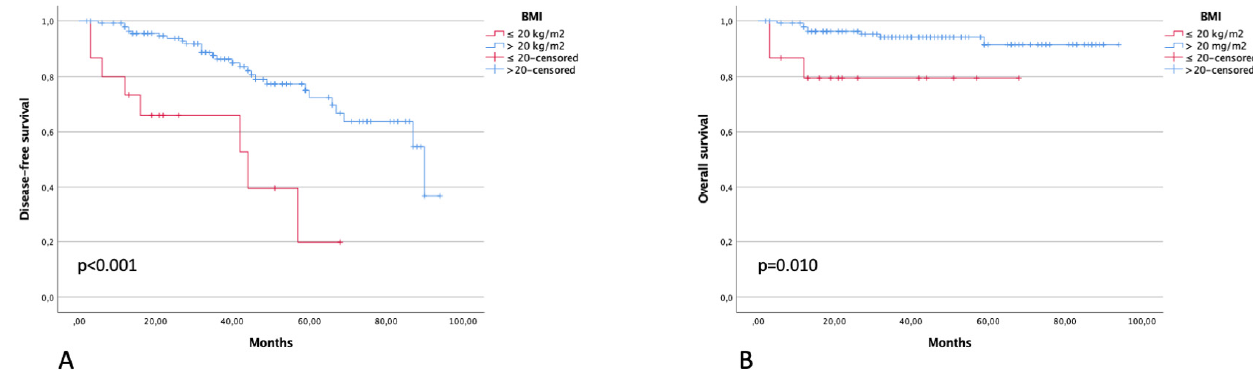
Figure 3. DFS ( A ) and OS ( B ) in patients with BMI of ≤ 20 and >20 kg/m 2 .